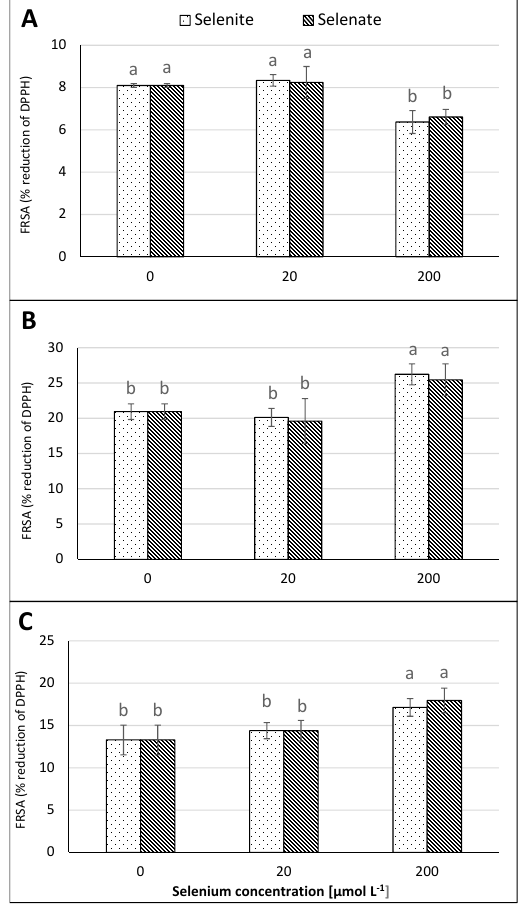
Fig. 3 Effects of selenium biofortification with selenite or selenate on free radical scavenging activity (FRSA) in the sprouts of alfalfa ( A ), radish ( B ), and white mustard ( C ). Means (± SD ; N = 6) with different letters on top of the bars are significantly different ( p < 0.05) according to Tukey’s LSD test.